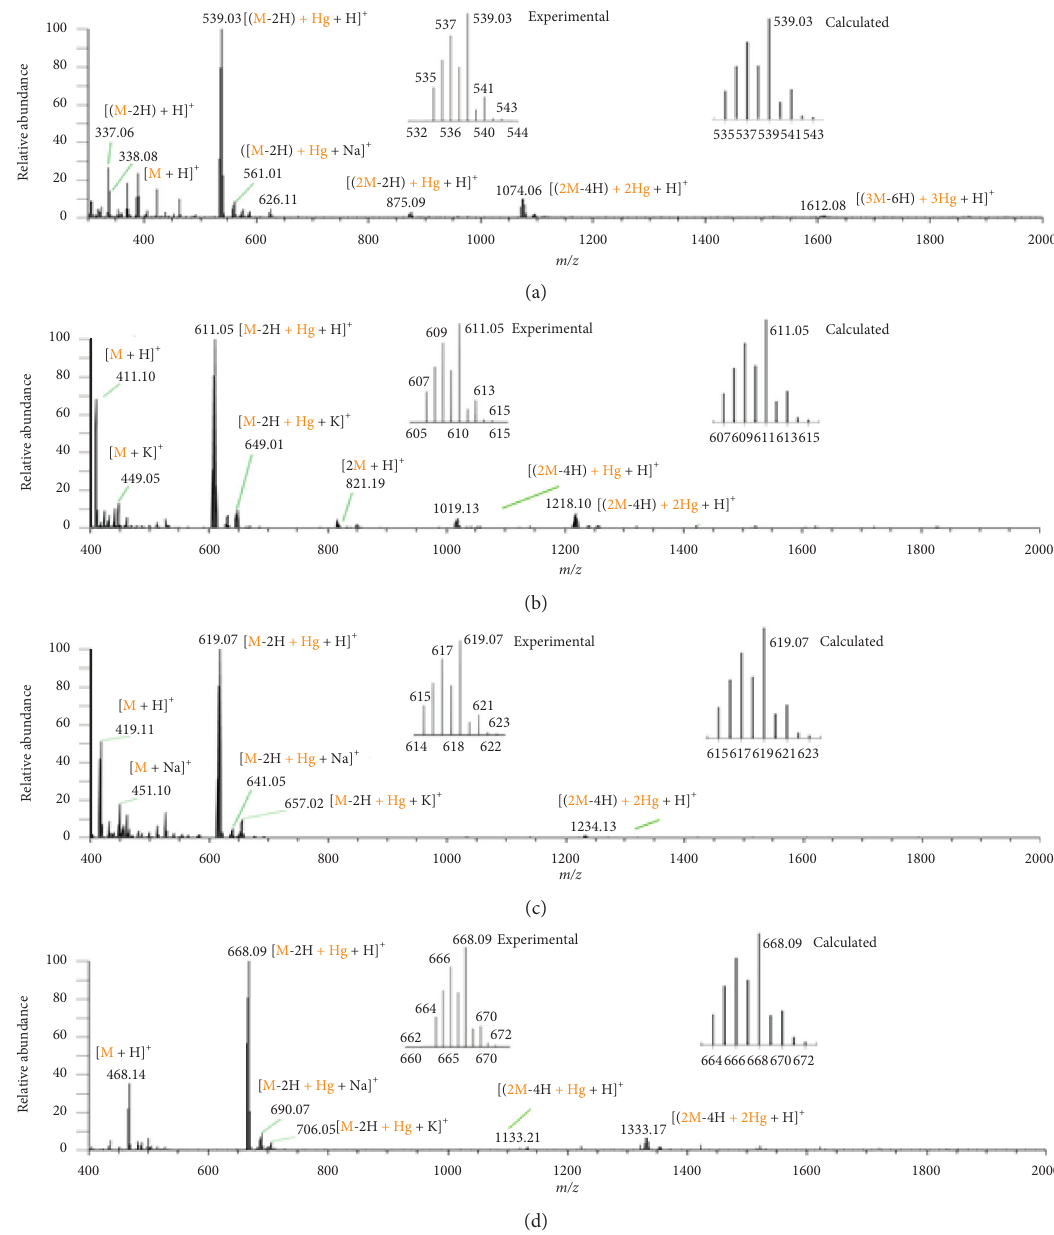
Figure 3: Electrospray ionization mass spectra of reaction mixtures containing 1 to 1 ratio of Hg(II):tetrapeptides. (a) GCGC +Hg 2+ , (b) ECGC +Hg 2+ , (c) HCGC +Hg 2+ , (d) WCGC +Hg 2+ , and the m/z value of the most intense peak in each isotopic cluster. Insets show the experimental and calculated mercury isotopic patterns for the 1:1 mercuriated peptide